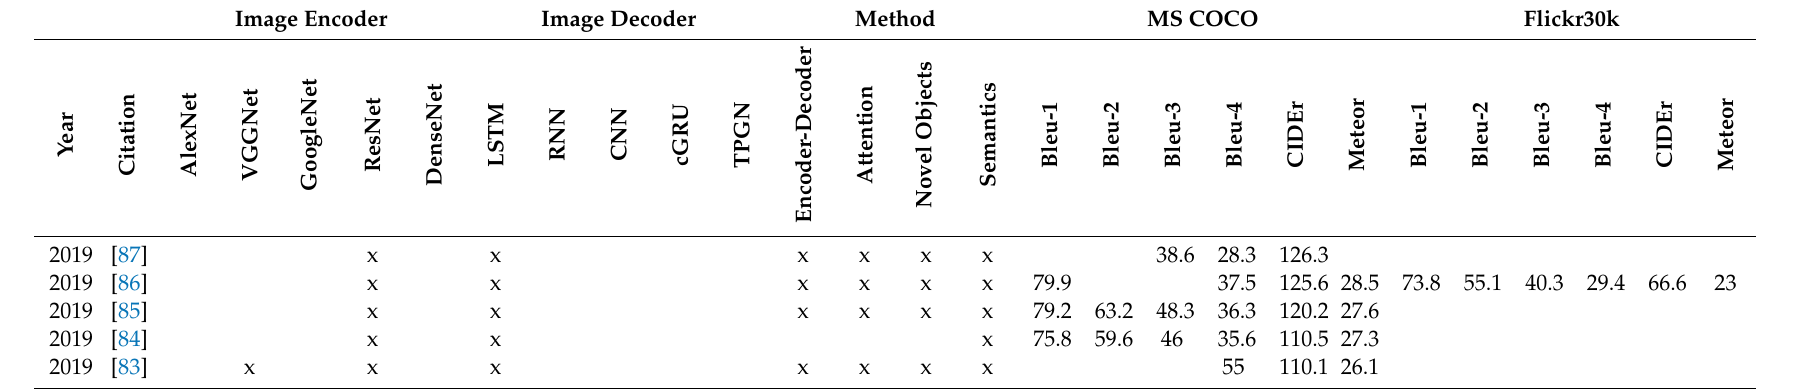
Table 8. Top 5 results in 2019 (sorted by CIDEr result on